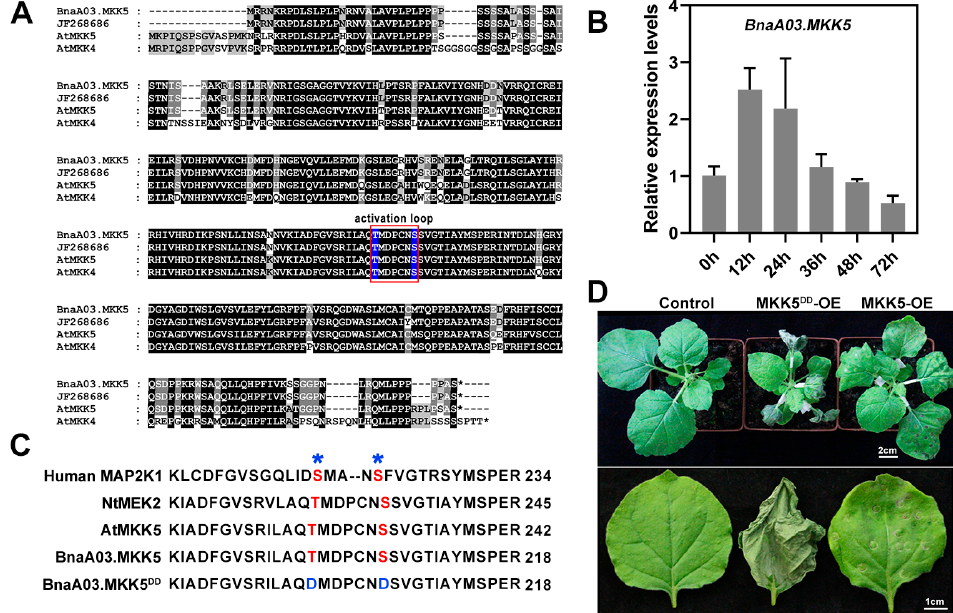
Figure 1. BnaA03.MKK5 is involved in defense response. ( A ) Sequence alignment of BnaA03.MKK5, JF268686, AtMKK5, and AtMKK4. The conserved amino acid residues are shown in black shading and similar residues are displayed in gray shading. The key motif activation loop is marked with red square frame, and conserved Ser/Thr is highlighted in blue. At, Arabidopsis thaliana ; Bna, Brassica napus . ( B ) Induced expression profiles of BnaA03.MKK5 were identified at 0 h, 12 h, 24 h, 36 h, 48 h, and 72 h after inoculation with S. sclerotiorum . Data are shown as means ± SD ( n = 3). ( C ) Diagram of the conserved Ser/Thr residues in the activation loop of BnaA03.MKK5. The target sites were detected via alignment to the homologous sequences in other species. BnaA03.MKK5 DD , conserved Ser/Thr mutated to Asp. Nt, Nicotiana benthamiana . ( D ) Constitutively active BnaA03.MKK5 DD induced hypersensitive response cell death. Hypersensitive response cell death induced by overexpression